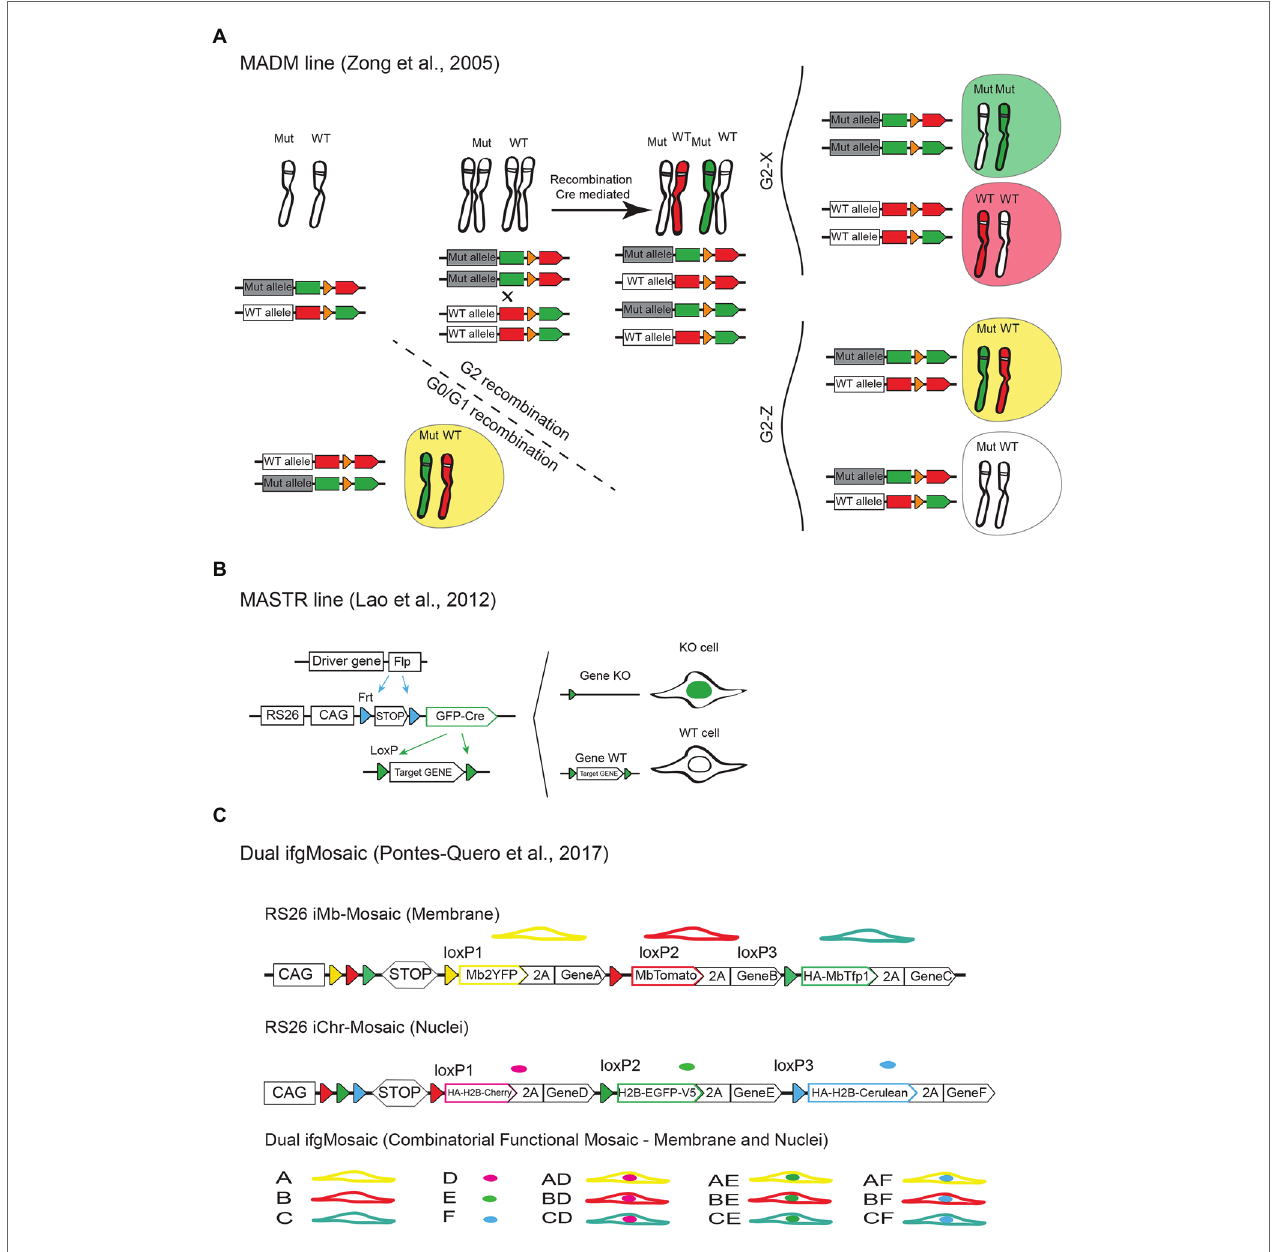
FIGURE 6 | Mouse alleles for functional genetic mosaics. (A) The MADM approach is dependent on rare interchromosomal and Cre-dependent recombination events between wildtype and mutant/KO alleles linked to the expression of different fluorescent proteins. This results in the labeling of wildtype (Wt) and mutant (Mut, homozygous or heterozygous) cells with different fluorescent proteins/colors. (B) Scheme of the MASTR mouse line and how it allows the Flp-recombinase dependent labelling of the nuclei of cells expressing GFP-Cre and therefore having a given floxed gene deleted (KO). Note that with this approach wildtype cells are not labelled. (C) Dual ifgMosaic alleles enable multispectral and combinatorial gene expression for accurate mosaic/clonal functional